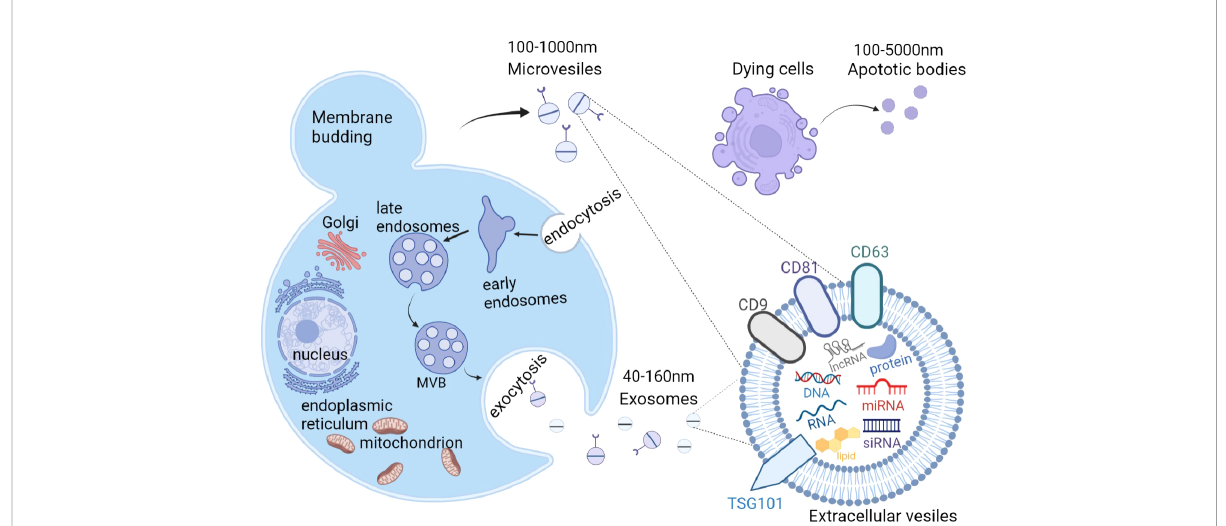
FIGURE 2 The biogenesis and content of extracellular vesicles(EVs). There are 3 subtypes of EVs, including exosomes, microvesicles (MVs), and apoptotic bodies. Exosomes are generated from the fusion of multivesicular bodies (MVBs) with the plasma membrane, ranging from 40-160nm while MVs are directly produced from the outward budding of the plasma membrane with a diameter of 100-1000nm. Apoptotic bodies are released from the blebbing of dying cells and the diameter is about 100 to 5000 nm. EVs contain proteins, lipids, nucleic acids (DNA, mRNA, siRNA, microRNA, and long noncoding RNAs), and multi-molecular complexes. EVs, extracellular vesicles; MVs, microvesicles; MVBs, multivesicular bodies. Figure created using BioRender